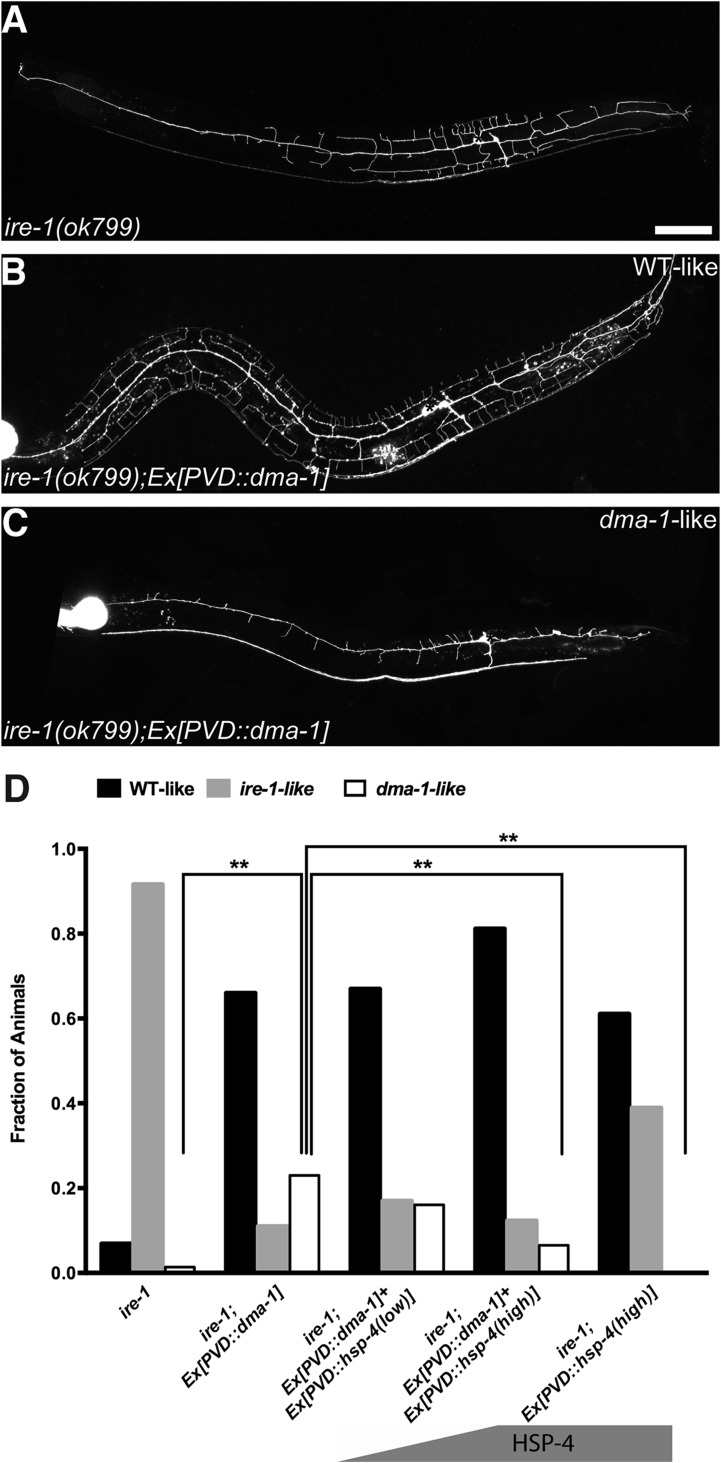
Overexpressing DMA-1 in ire-1 mutants can either rescue dendritic defects or cause more severe dendrite branching defects.(A) Representative defective PVD dendritic arbor in ire-1 mutants. (B and C) Overexpressing DMA-1 in PVD in ire-1 mutants rescues the dendritic defect (WT-like) (B) or causes a more severe phenotype with fewer branches (dma-1-like) (C). Asterisks, cell bodies; Scale bar, 50 μm. (D) Proportions of different phenotypes in different transgenic rescue strains with overexpression of dma-1 and/or supplementation of different doses of HSP-4 chaperon. n > 120. **p < 0.01, χ2 test with Sidak's multiple comparison correction.